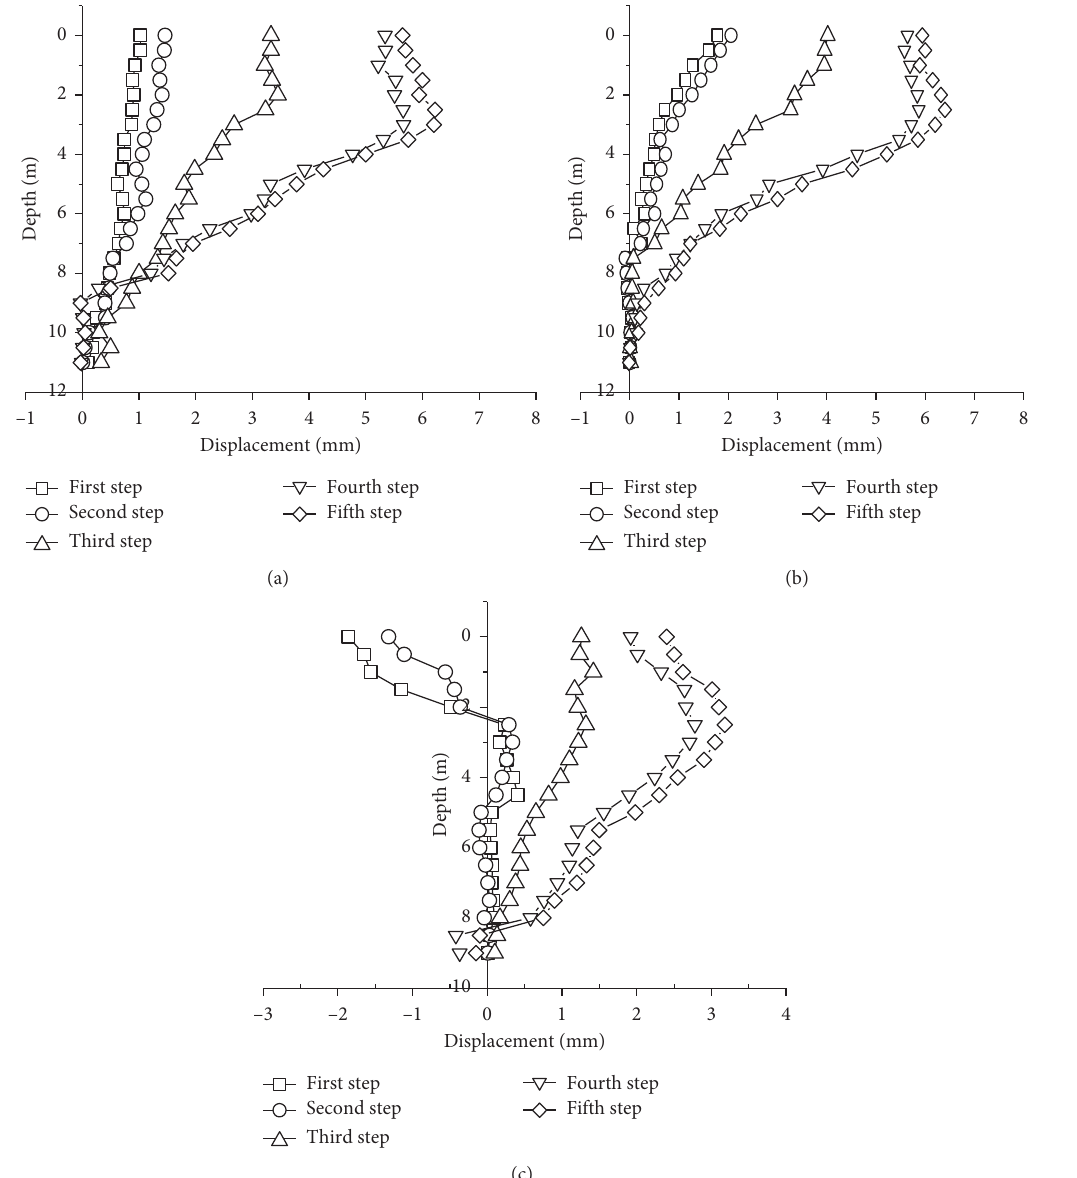
Figure 16: Horizontal displacement of front row piles. (a) Conventional front row pile. (b) Recycling assembled front row pile. (c) Prestressed strong-constrained front row